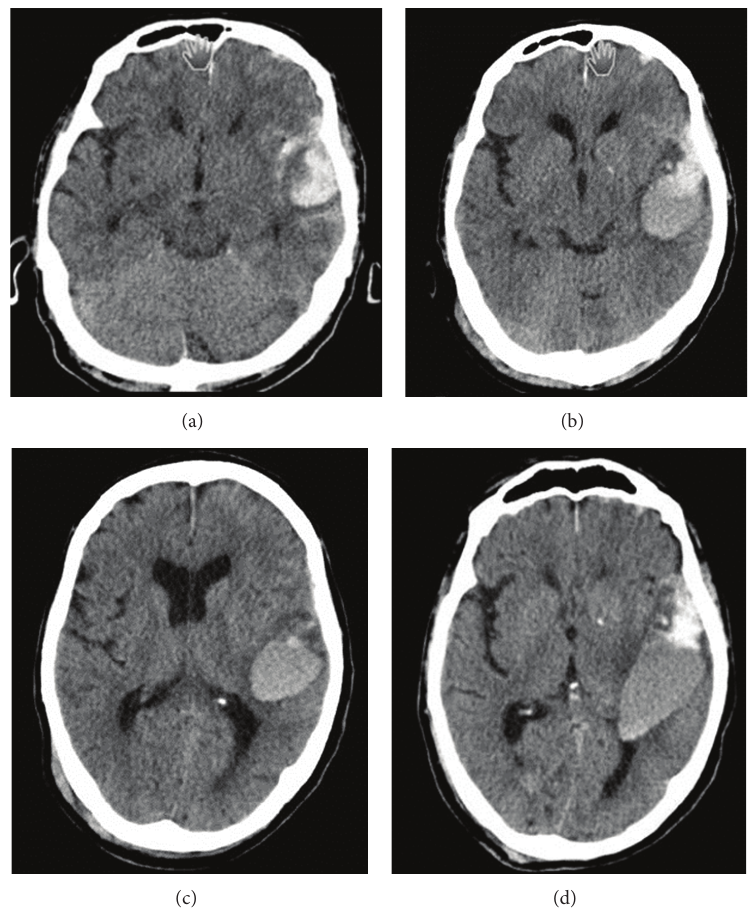
Figure 3: Spontaneous course of traumatic intracerebral haemorrhage with platelet aggregation inhibitor: 79-year-old patient hit by a car when walking in the city. On admission, he had a Glasgow Coma Score of 13. Findings on admission were left temporal contusion (a) which had increased in size after 24 hours (b). The patient then developed dysphasia. Although there was only a slight increase in size after a further 4 days, with the clinical condition remaining stable (c), an additional, relevant progression in size was noted on day 5 in the presence of seizures (d). Surgery was not performed since the patient never lost consciousness and did not develop severe hemiparesis.